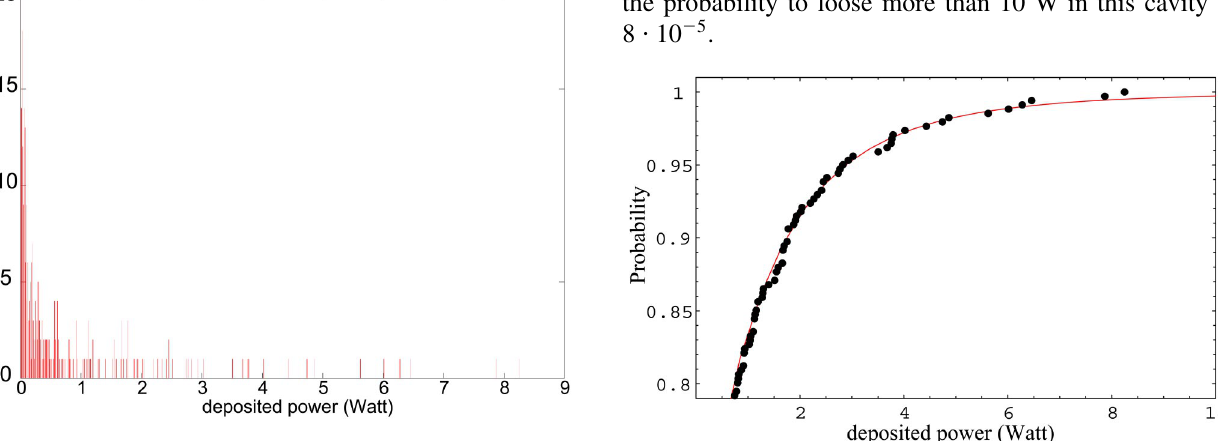
FIG. 22. (Color) GEV fitted with the recorded losses for the quadrupole. The deposited beam power (W) forms the abscissa and the CDF the